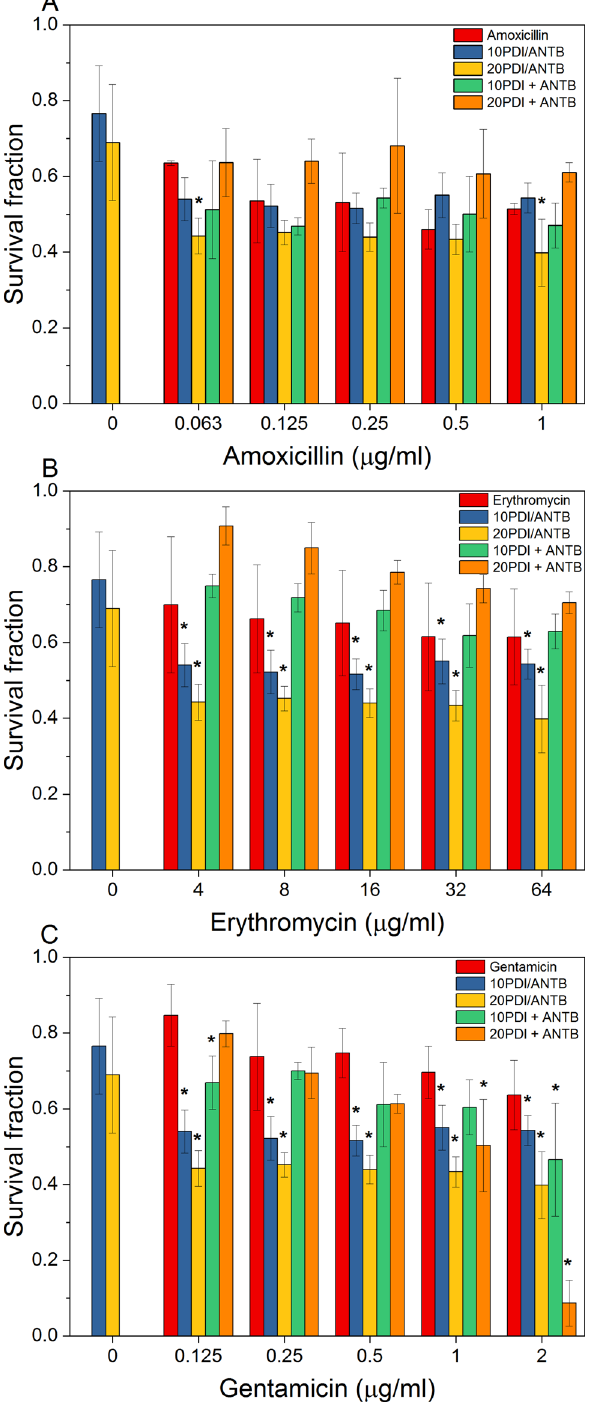
Figure 2. Survival curve of combined treatments by oxidative stress (PDI/ANTB) and Simultaneous internalization (PDI + ANTB) with application of 10 μM of curcumin and 10 and 20 J/cm 2 . ( A ) Amoxicillin, ( B ) Erythromycin, ( C ) Gentamycin. Normalizations performed for untreated bacteria. *indicates synergistic combination for Bliss